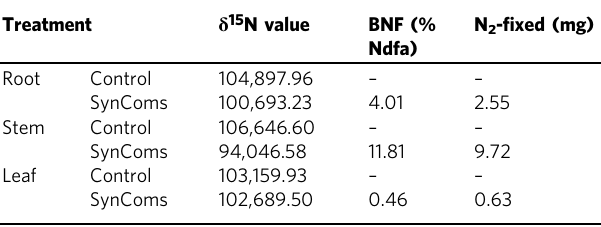
Table 1 Contribution of biological N- fi xation by SynComs to N nutrition of roots, stems, and leaves of maize plants grown in medium containing 15